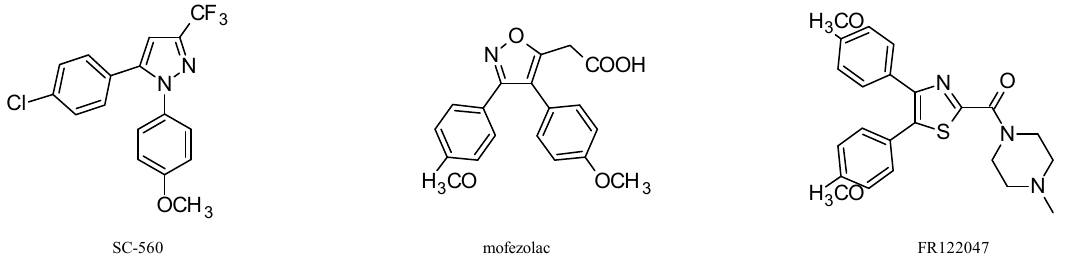
Figure 1. COX-1-selective inhibitors investigated for anticancer properties. SC-560,5-(4-chlorophenyl)-1-(4-methoxyphenyl)-3-(trifluoromethyl)pyrazole; mofezolac, (3,4-bis(4-methoxyphenyl)-5-isoxazolyl)acetic acid; FR122047, 1-((4,5-bis(4-methoxyphenyl)-2-thiazoyl)carbonyl)-4-methylpiperazine.